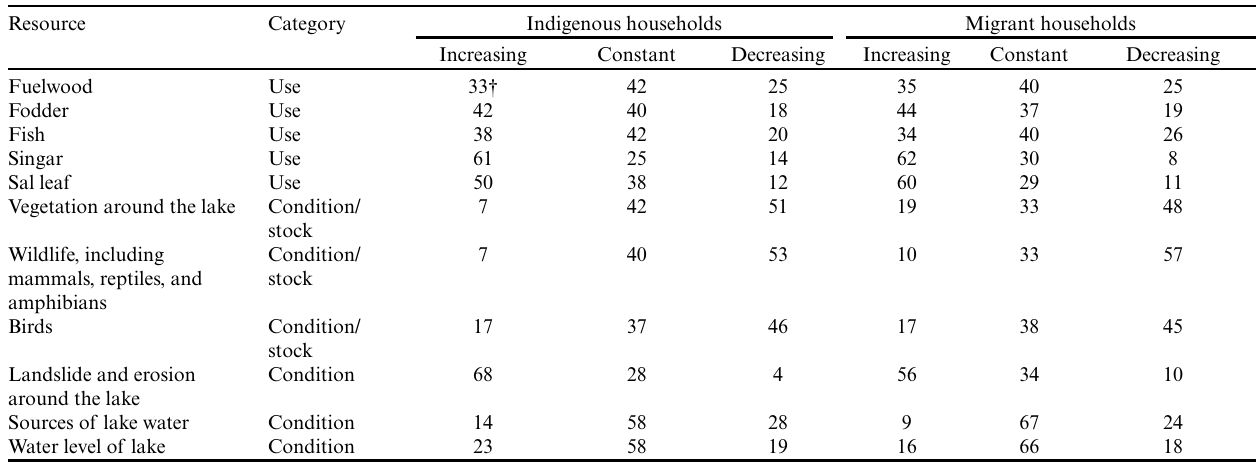
Table 4. Households’ perceptions of trends in sustainability for Ghodaghodi Lake resources during 1998–2007. Resource